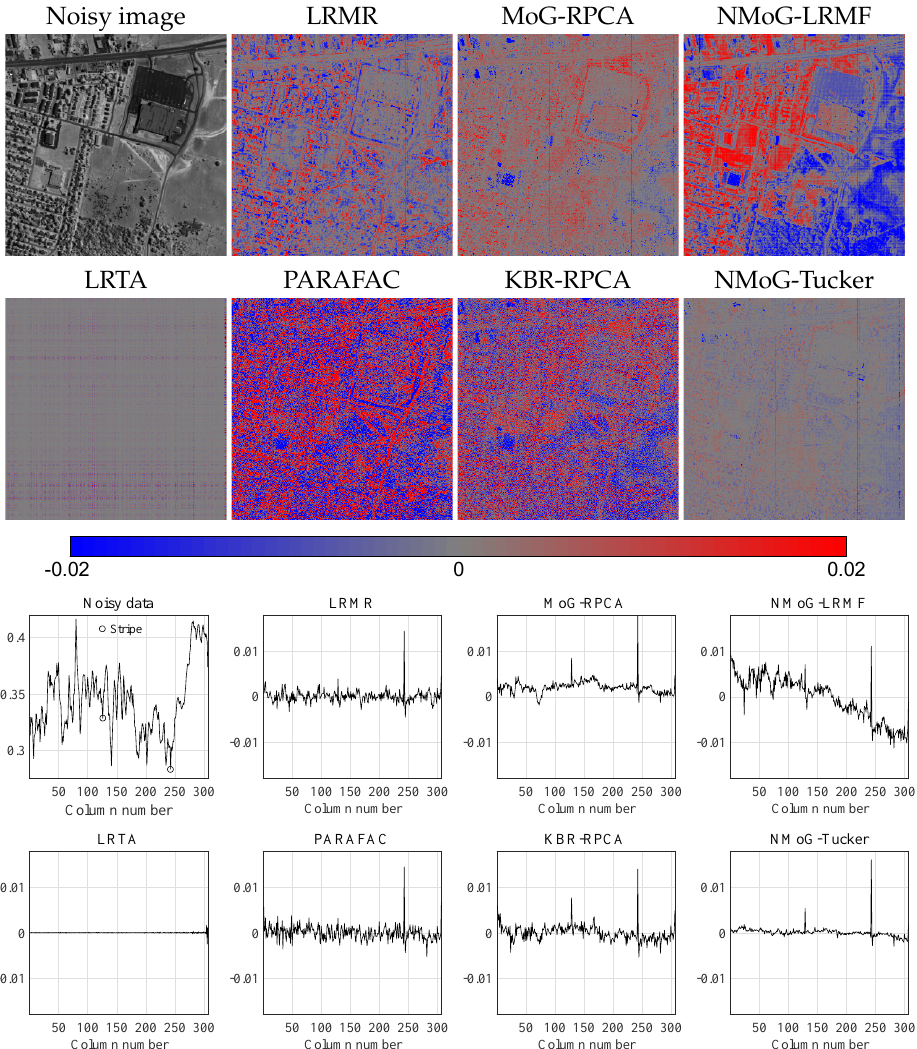
Figure 8. Real HSI denoising example on band 99 in Urban under slight noise. Top two rows: the noisy image and color maps of the noise components estimated by different methods (difference between the noisy image and its denoised version). Results highlighting more noise and fewer image structures indicate better denoising performance. Bottom two rows: the corresponding vertical mean profiles, where we mark the locations of stripes by circles in the noisy